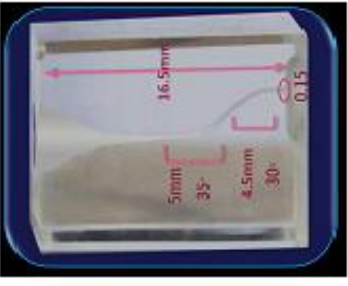
Figure 1: S-Shaped Simulated Canal. Prior to experimental instrumentation of the resin blocks, all canals were stained with blue ink to obtain a clear image of the canal. Three landmarks were made with a round bur in the resin blocks from sidewall to near the inner and outer curve of the canal without penetrating into the canal. These landmarks ensured a precise alignment during superimposition of pre- and post- instrumentation images. The resin blocks were then numbered for identification.